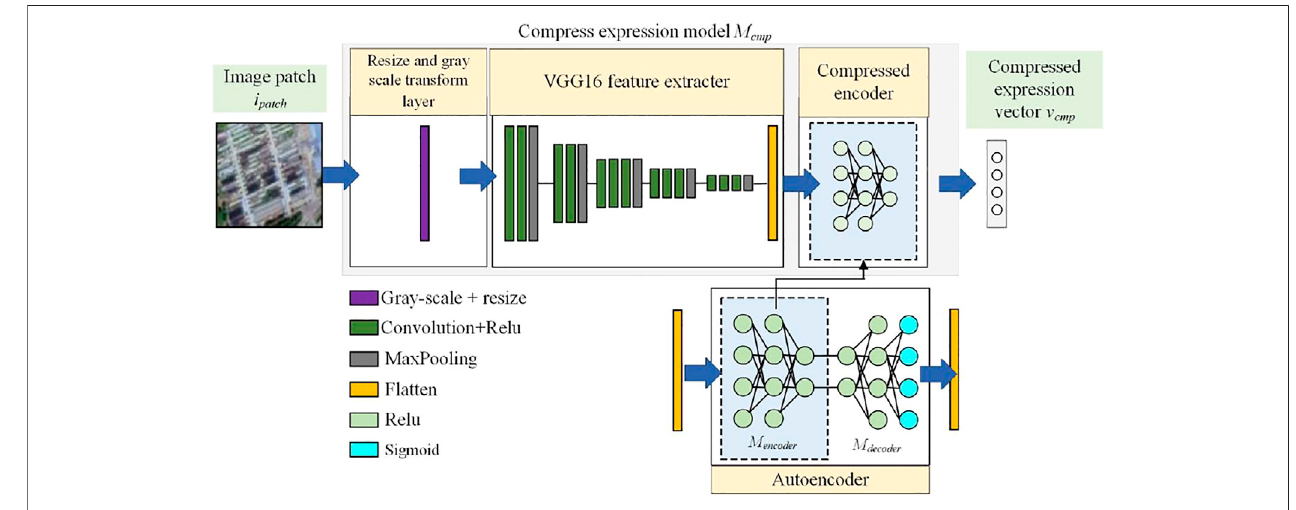
FIGURE 3 | Structure of M cmp